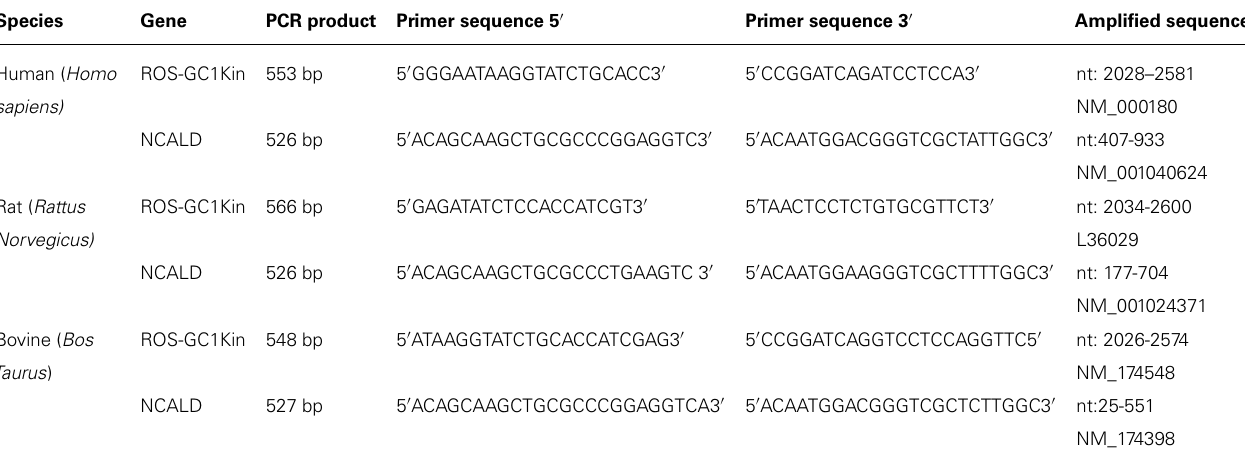
Table 1 | Primers used in PCR. Species Primer sequence 3 (cid:3) Amplified